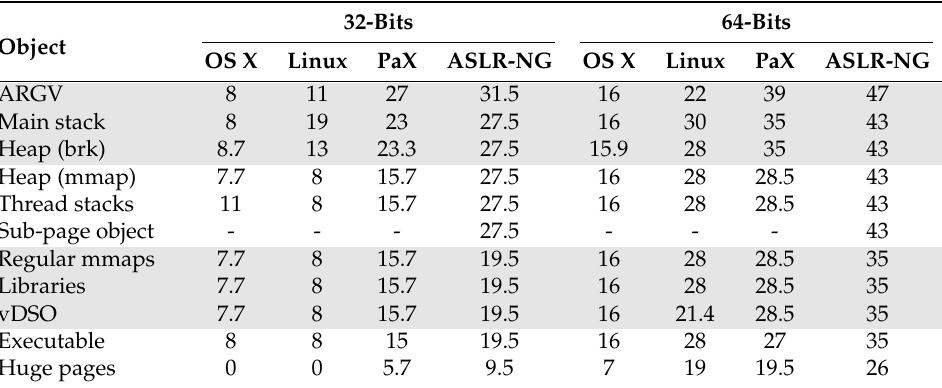
Table 5. Comparative summary of bits of